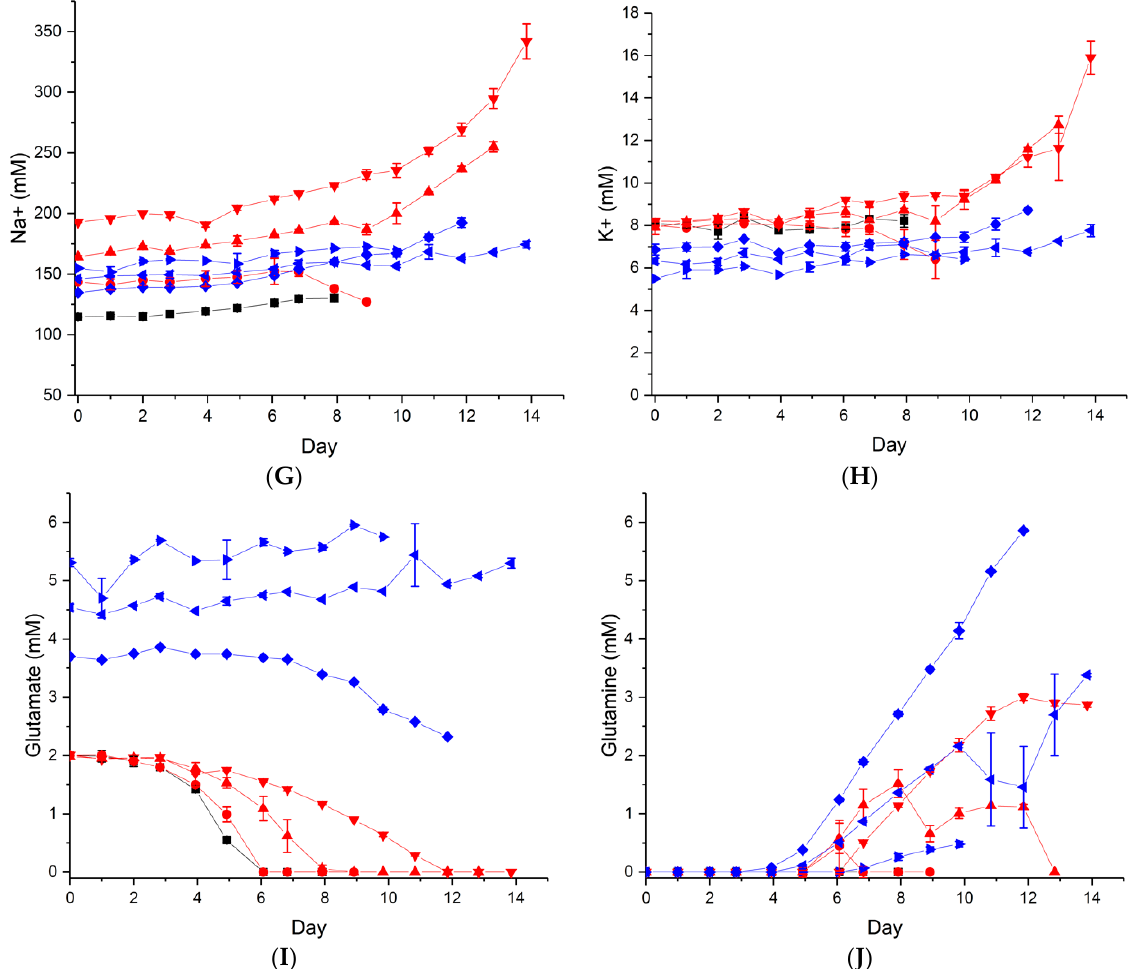
Figure 2. Time evolution of cell culture parameters under different osmolality conditions. ( A ) Viable cell density; ( B ) Osmolality value; ( C ) Average cell diameter; ( D ) Extracellular ammonia concentration; ( E ) Extracellular lactate concentration; ( F ) Extracellular glucose concentration; ( G ) Extracellular Na + concentration; ( H ) Extracellular K + concentration; ( I ) Extracellular glutamate concentration; ( J ) Extracellular glutamine concentration. Error bars represent the standard deviation of two biological replicates, except for the average cell diameter, which shows standard errors.